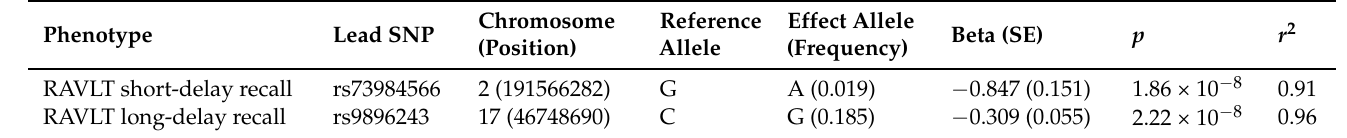
Table 2. Genomic loci associated with verbal